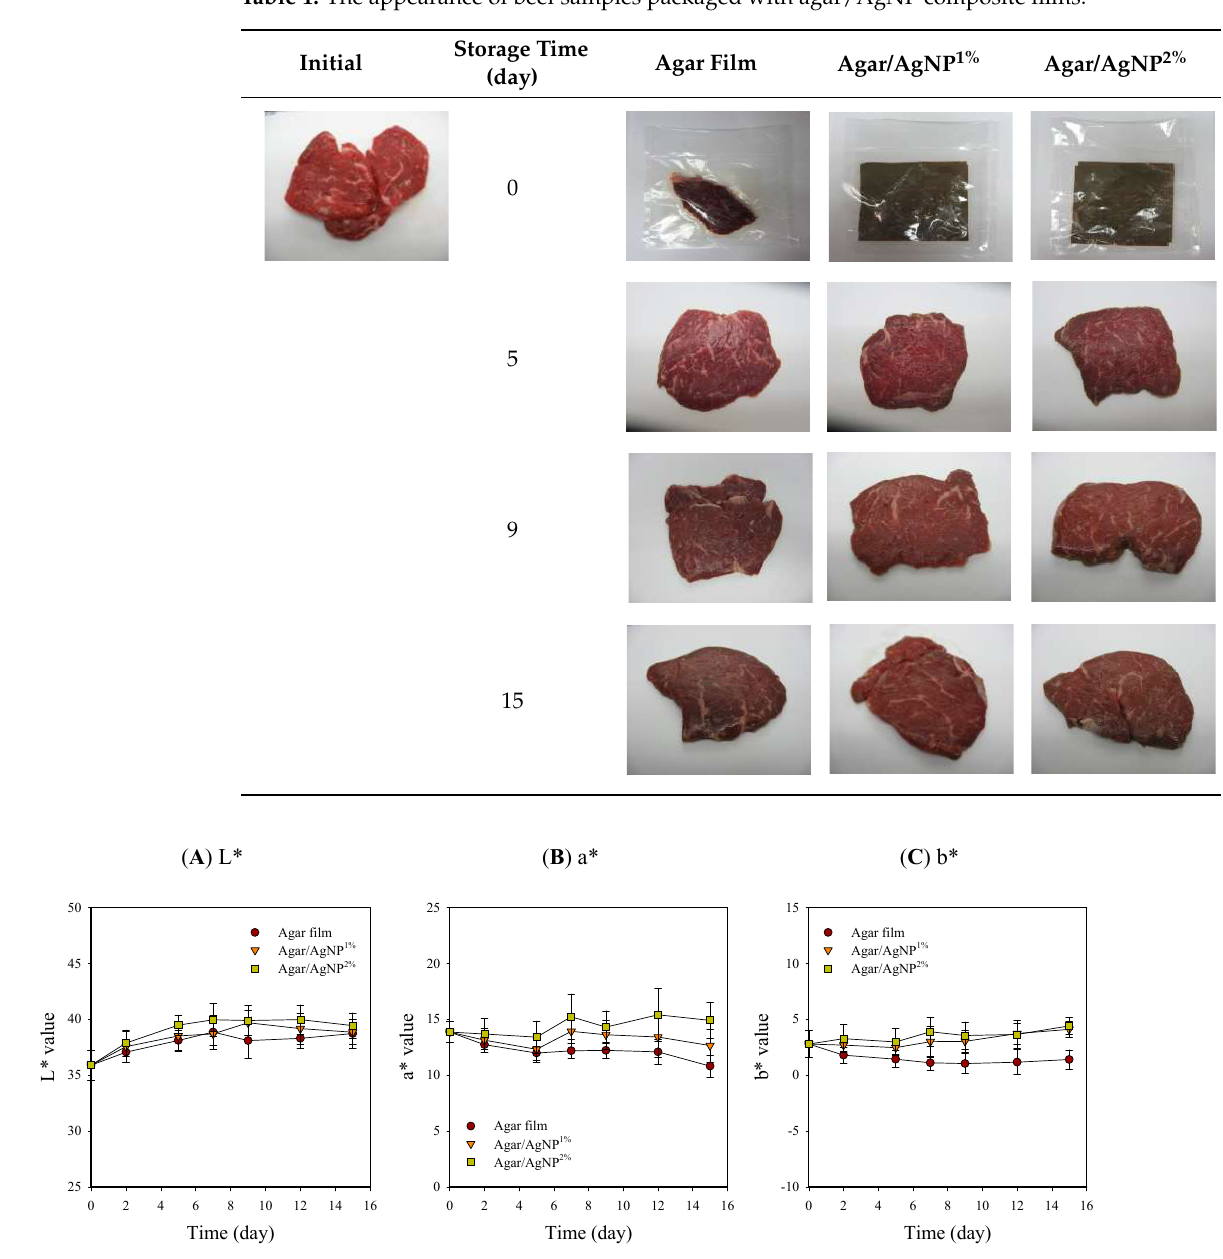
Figure 3. Changes in L* ( A ), a* ( B ), and b* ( C ) values of beef samples packaged with agar/AgNP composite films. L* value: Figure 3. Changes in L* (A), a* (B), and b* (C) values of beef samples packaged with agar/AgNP composite films. L* value: LSD time = 0.42, LSD treatment = 0.27. a* value: LSD time = 0.48, LSD treatment = 0.30. b* value: LSD time = 0.34, LSD treatment = Figure 3. Changes in L* (A), a* (B), and b* (C) values of beef samples packaged with agar/AgNP composite films. L* value: Figure 3. Changes in L* (A), a* (B), and b* (C) values of beef samples packaged with agar/AgNP composite films. L* value: Figure 3. Changes in L* (A), a* (B), and b* (C) values of beef samples packaged with agar/AgNP composite films. L* value: LSD time = 0.42, LSD treatment = 0.27. a* value: LSD time = 0.48, LSD treatment = 0.30. b* value: LSD time = 0.34, LSD treatment = 0.22. Figure 3. Changes in L* (A), a* (B), and b* (C) values of beef samples packaged with agar/AgNP composite films. L* value: Figure 3. Changes in L* (A), a* (B), and b* (C) values of beef samples packaged with agar/AgNP composite films. L* value: Figure 3. Changes in L* (A), a* (B), and b* (C) values of beef samples packaged with agar/AgNP composite films. L* value: Figure 3. Changes in L* (A), a* (B), and b* (C) values of beef samples packaged with agar/AgNP composite films. L* value: Figure 3. Changes in L* (A), a* (B), and b* (C) values of beef samples packaged with agar/AgNP composite films. L* value: Figure 3. Changes in L* (A), a* (B), and b* (C) values of beef samples packaged with agar/AgNP composite films. L* value: Figure 3. Changes in L* (A), a* (B), and b* (C) values of beef samples packaged with agar/AgNP composite films. L* value: Figure 3. Changes in L* (A), a* (B), and b* (C) values of beef samples packaged with agar/AgNP composite films. L* value: Figure 3. Changes in L* (A), a* (B), and b* (C) values of beef samples packaged with agar/AgNP composite films. L* value: Figure 3. Changes in L* (A), a* (B), and b* (C) values of beef samples packaged with agar/AgNP composite films. L* value: LSD time = 0.42, LSD treatment = 0.27. a* value: LSD time = 0.48, LSD treatment = 0.30. b* value: LSD time = 0.34, LSD treatment = 0.22. LSD time = 0.42, LSD treatment = 0.27. a* value: LSD time = 0.48, LSD treatment = 0.30. b* value: LSD time = 0.34, LSD treatment = 0.22. LSD time = 0.42, LSD treatment = 0.27. a* value: LSD time = 0.48, LSD treatment = 0.30. b* value: LSD time = 0.34, LSD treatment = 0.22. LSD time = 0.42, LSD treatment = 0.27. a* value: LSD time = 0.48, LSD treatment = 0.30. b* value: LSD time = 0.34, LSD treatment = 0.22. LSD time = 0.42, LSD treatment = 0.27. a* value: LSD time = 0.48, LSD treatment = 0.30. b* value: LSD time = 0.34, LSD treatment = 0.22. LSD time = 0.42, LSD treatment = 0.27. a* value: LSD time = 0.48, LSD treatment = 0.30. b* value: LSD time = 0.34, LSD treatment = 0.22. LSD time = 0.42, LSD treatment = 0.27. a* value: LSD time = 0.48, LSD treatment = 0.30. b* value: LSD time = 0.34, LSD treatment = 0.22. LSD time = 0.42, LSD treatment = 0.27. a* value: LSD time = 0.48, LSD treatment = 0.30. b* value: LSD time = 0.34, LSD treatment = 0.22. LSD time = 0.42, LSD treatment = 0.27. a* value: LSD time = 0.48, LSD treatment = 0.30. b* value: LSD time = 0.34, LSD treatment = 0.22. LSD time = 0.42, LSD treatment = 0.27. a* value: LSD time = 0.48, LSD treatment = 0.30. b* value: LSD time = 0.34, LSD treatment = 0.22. LSD time = 0.42, LSD treatment = 0.27. a* value: LSD time = 0.48, LSD treatment = 0.30. b* value: LSD time = 0.34, LSD treatment = 0.22. LSD time = 0.42, LSD treatment = 0.27. a* value: LSD time = 0.48, LSD treatment = 0.30. b* value: LSD time = 0.34, LSD treatment = 0.22. LSD time = 0.42, LSD treatment = 0.27. a* value: LSD time = 0.48, LSD treatment = 0.30. b* value: LSD time = 0.34, LSD treatment = 0.22.